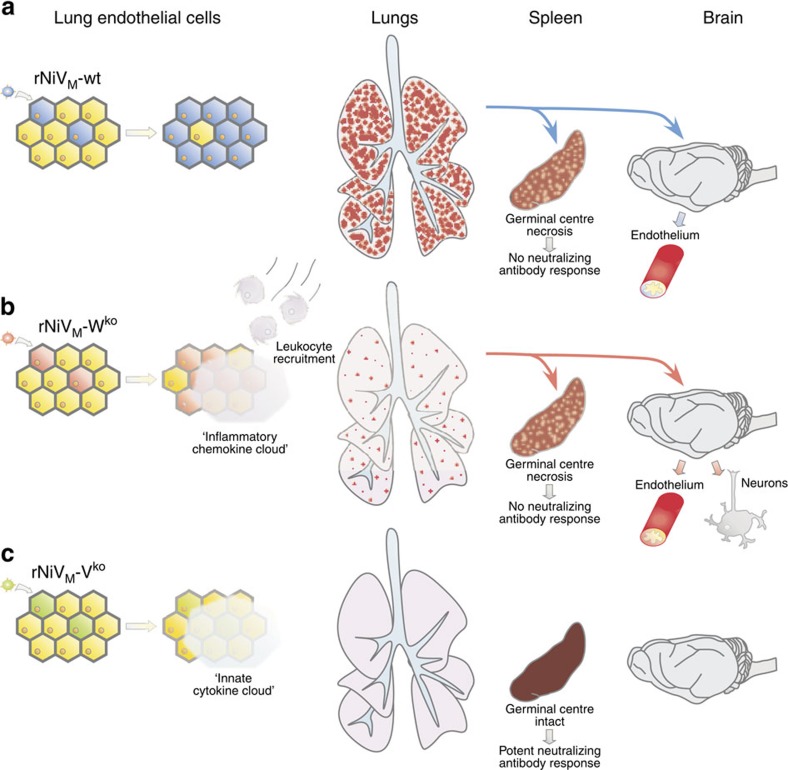
Model of the immunomodulating roles of the NiV W and V proteins in ferret pathogenesis.rNiVM-wt (a) spreads unhindered in early target lung endothelial cells (Fig. 2d) leading to extensive lung injury (Fig. 5a) followed by spread to the spleen (Fig. 5b) causing germinal centre necrosis (Fig. 6c) leading to a lack of neutralizing antibody response (Fig. 4d); there is also spread to the endothelium of the brain (Fig. 7d) and moderate neurological signs develop before the ferret succumbs to pulmonary disease. rNiVM-Wko (b) allows lung endothelial cells to generate an ‘inflammatory chemokine cloud' (Fig. 3 and Supplementary Table 1) somewhat hindering viral titres (Fig. 2d) and presumably allowing increased leukocyte recruitment to the lungs, limiting lung injury (Fig. 5d) and sequestering most viral spread to the endothelium and distinctive inflammatory nodules (Fig. 7f), thus causing milder respiratory signs; rNiVM-Wko is still able to spread to the spleen (Fig. 5e) causing germinal centre necrosis (Fig. 7g) and leading to a lack of neutralizing antibody response (Fig. 4d); there is also spread to the brain endothelium and, owing to prolonged time to death, eventually neurons as well leading to severe neurological signs and succumbing to neurological disease. rNiVM-Vko (C) in unable to grow efficiently in lung endothelial cells (Fig. 2d) possibly due to the production of an ‘innate cytokine cloud' (Fig. 3 and Supplementary Table 1) and is unable to efficiently spread or cause injury in the lungs (Fig. 5g), spleen (Fig. 5h) or brain (Fig. 7l); the splenic germinal centres remain intact (Fig. 6k) and a potent neutralizing antibody response develops (Fig. 4d) that leads to viral clearance and 100% ferret survival.